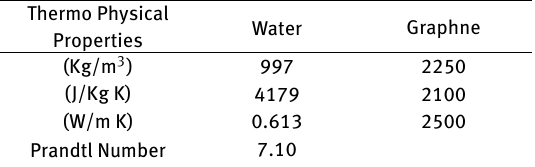
Table 2: Thermo physical properties of water andare given